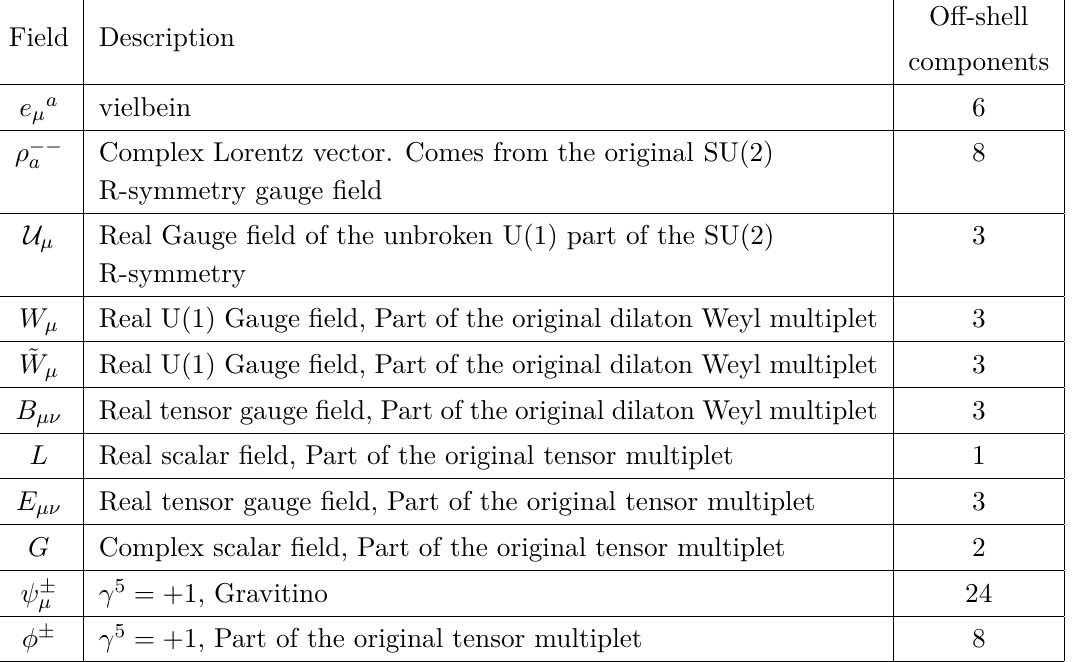
Table 7 . N = 2 Poincaré supergravity